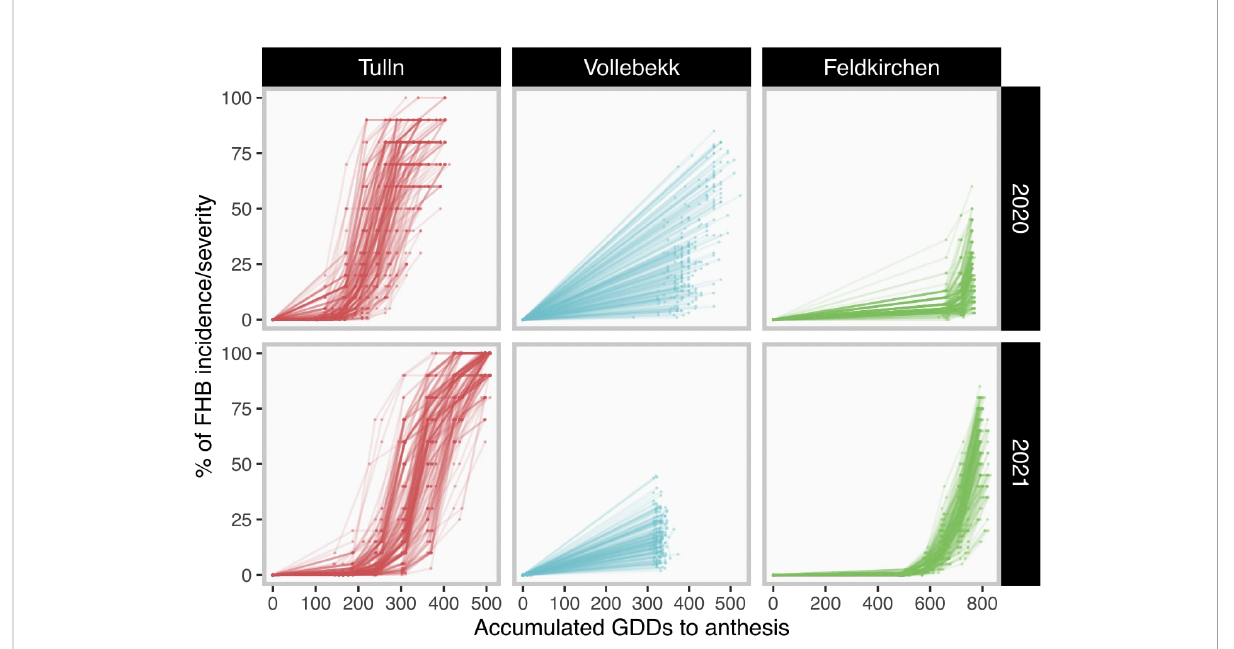
FIGURE 1 Disease development among trials. Each fi eld trial is graphed in one grid. Grids in the same column have a common location (Tulln, Vollebekk and Feldkirchen, from partners BOKU, NMBU and Secobra, respectively). Grids in the same row have common season (2020 or 2021). Each curve represents the disease development in one plot. Dots represent fi eld assessments and curves are constructed by connecting them. The percentage of FHB incidence/severity is assumed to be null on